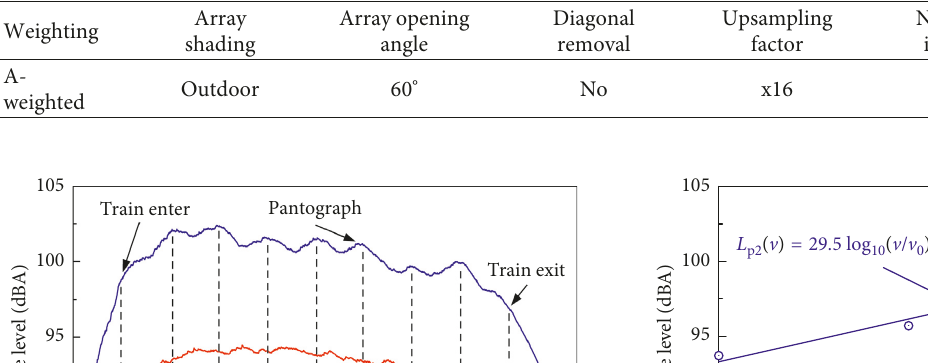
Table 1: The parameters used in the